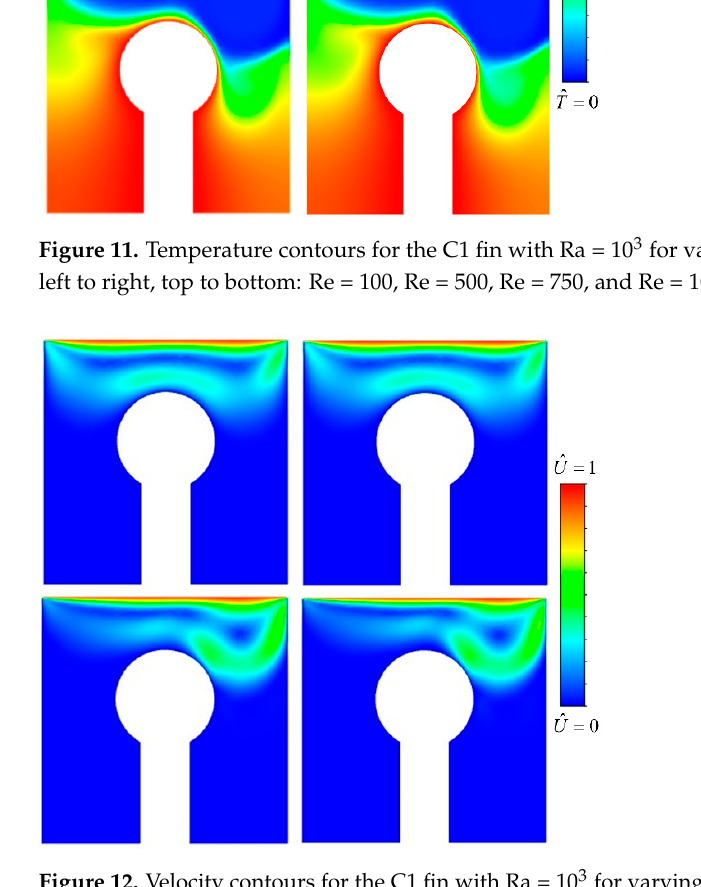
Figure 12. Velocity contours for the C1 fin with Ra = 10 3 for varying Raynolds numbers. From left to right, top to bottom: Re = 100, Re = 500, Re = 750, and Re = 1000.